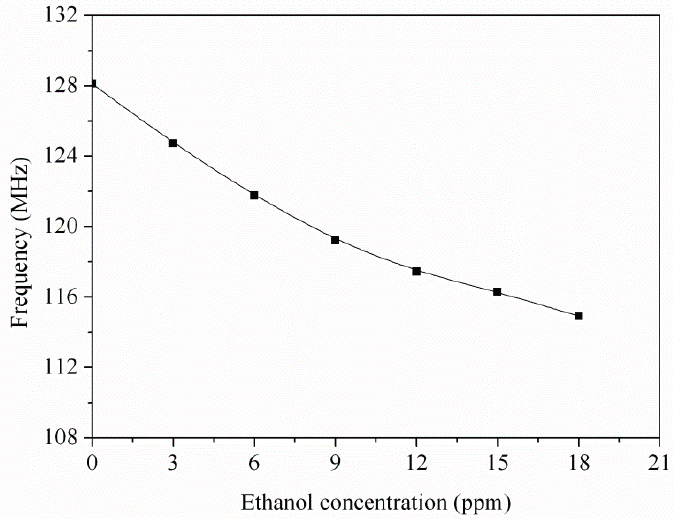
Figure 12. Measured results of the output frequency for the integrated ethanol